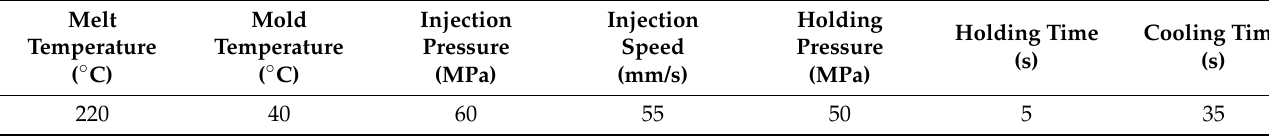
Table 1. The molding parameters used in EGAIM and